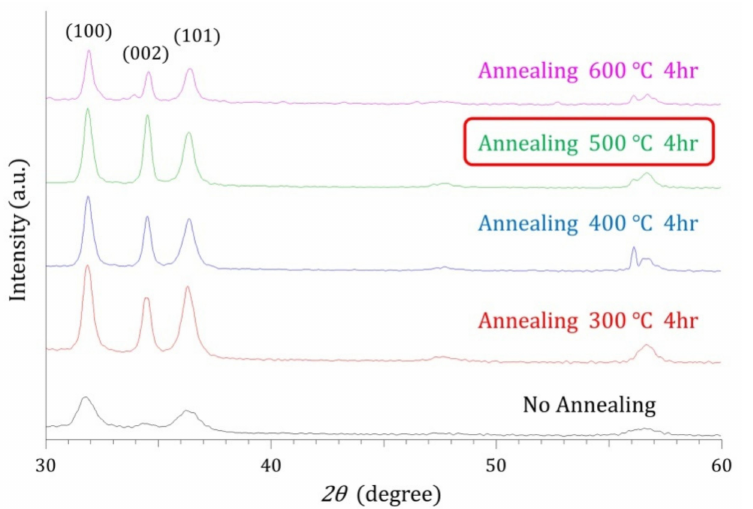
Figure 7. XRD patterns of as-deposited ZnO film and ZnO films annealed at temperatures in the range of 300–600 ◦